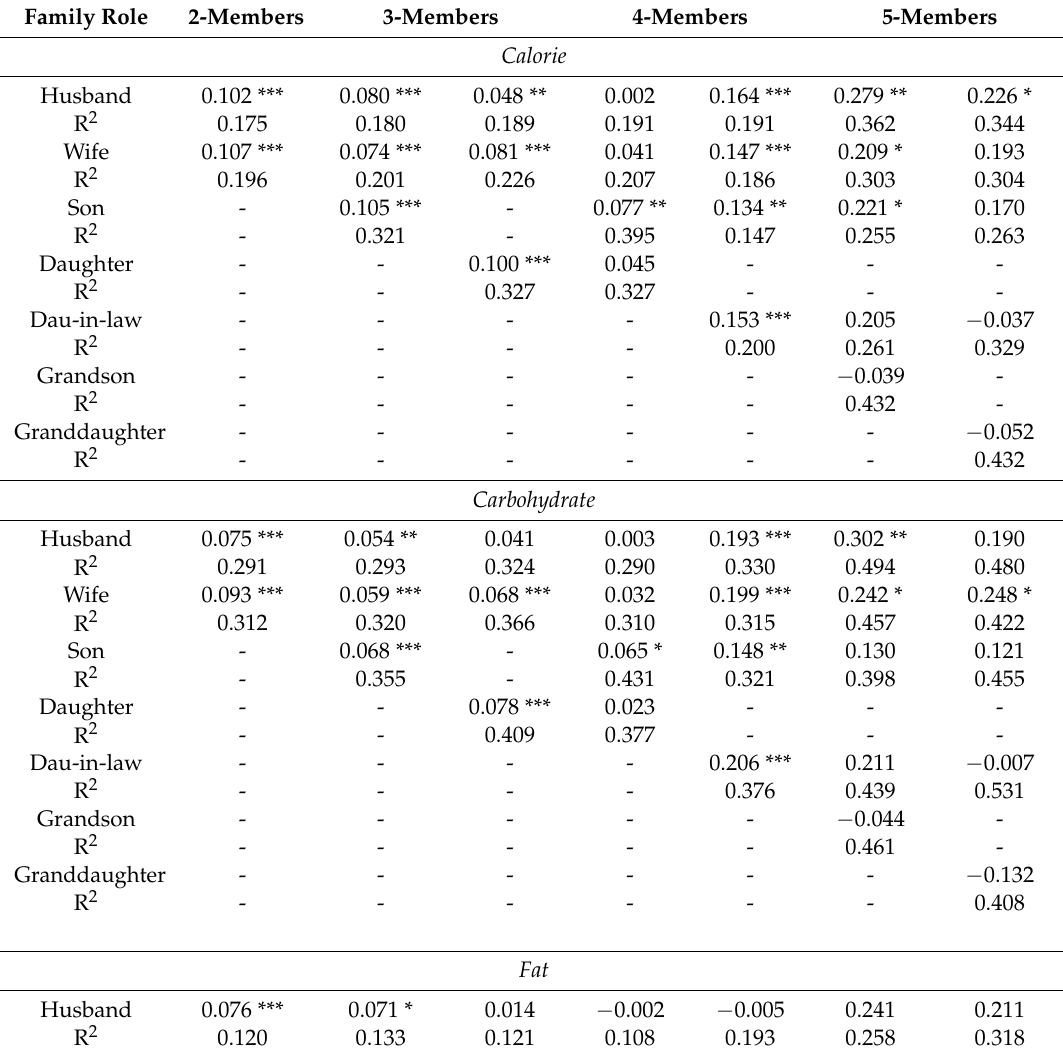
Table 5. Rural multiple members’ joint consumption effect (dependent variable: ln individual calorie, carbohydrate, fat and